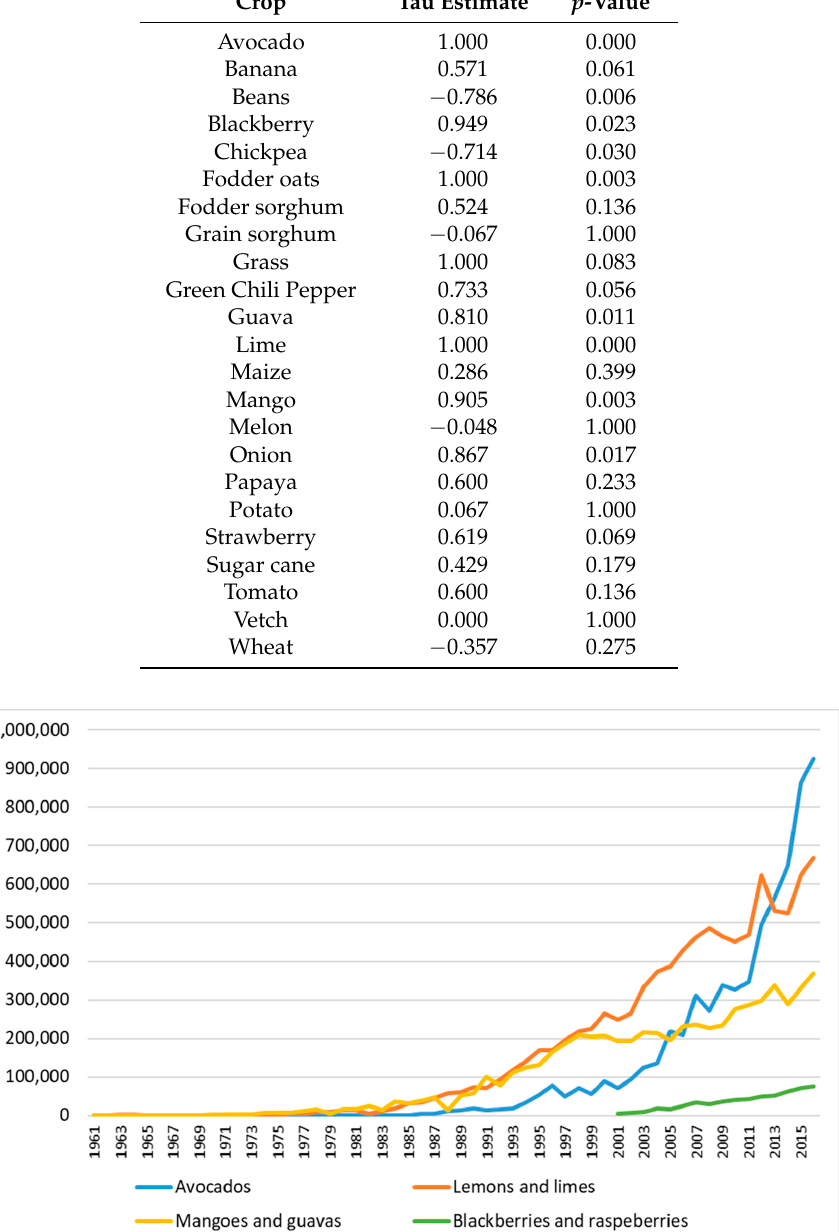
Table 3. Harvested area trends for each crop in Michoac á n state from 1950 to 2015.